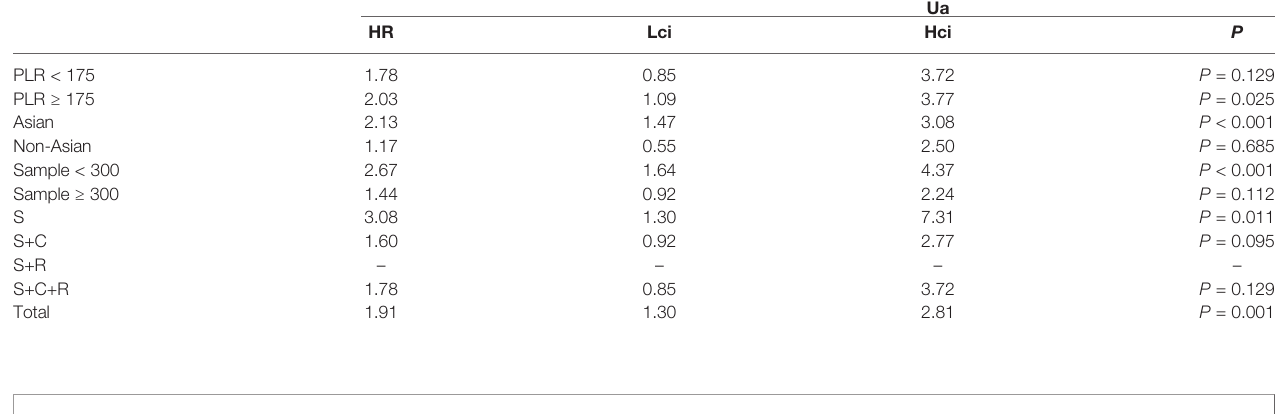
TABLE 6 | The results of the subgroup analysis for platelet – lymphocyte ratio (PLR) and disease-free survival are summarized below.